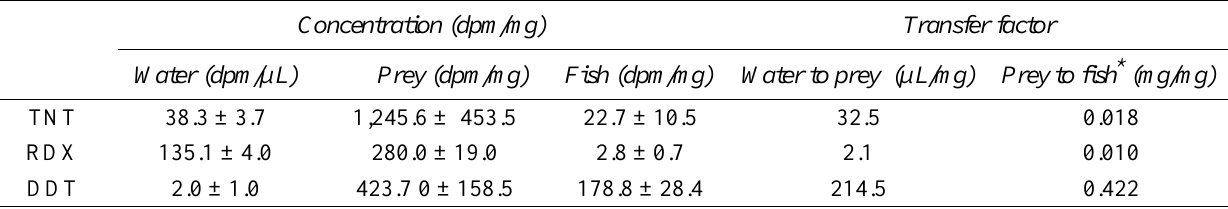
Table 1: Radioactivity in water, prey ( Lumbriculus variegatus ) , and fish ( Pimephales promelas ) expressed as mean (± 1 standard deviation) disintegrations per minute (dpm) per unit of volume or mass representing the total concentration of the parent compounds (TNT, RDX or DDT) and all their degradation products. Transfer factors represent the ratio between prey body residue (dpm/mg) and water concentration (dpm/L) and between fish body burden (dpm/mg) and prey body burden